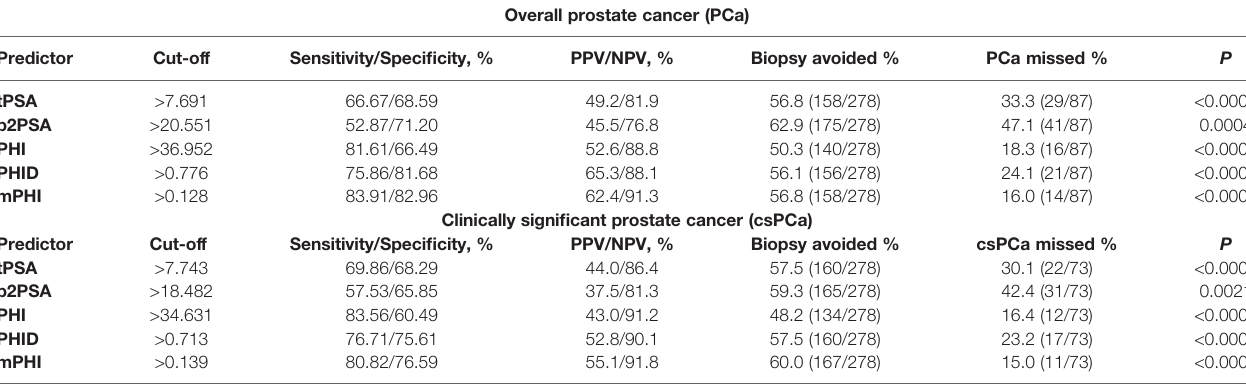
Overall prostate cancer (PCa)